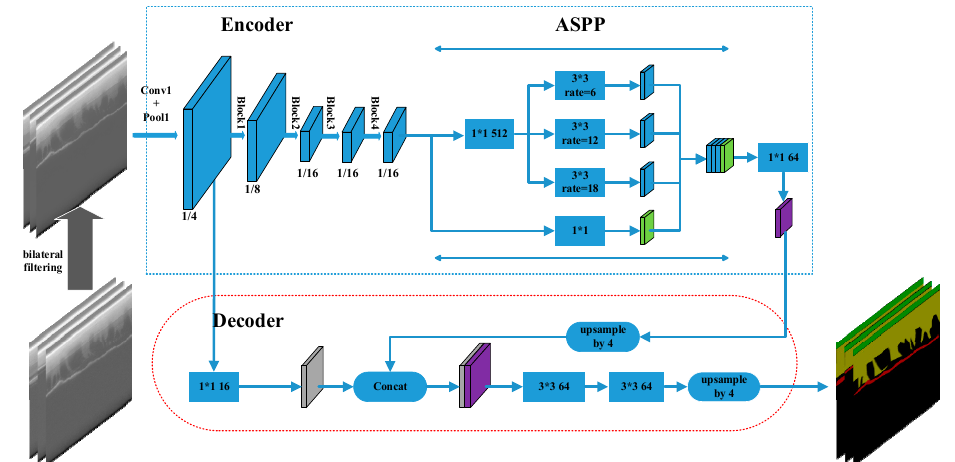
Figure 2. Our network architecture consists of ResNet module, improved atrous spatial pyramid pooling (ASPP) module and decoder module.